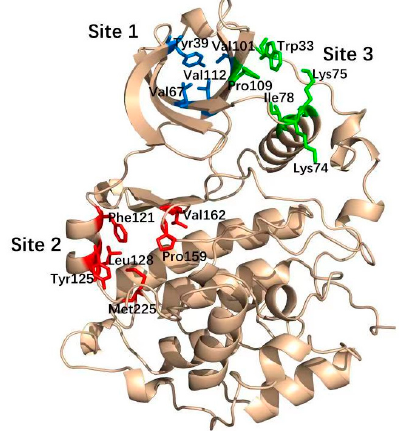
Figure 1. Three well-elucidated allosteric sites of CK2 α including Site 1 (blue), Site 2 (red) and Site 3 (green).